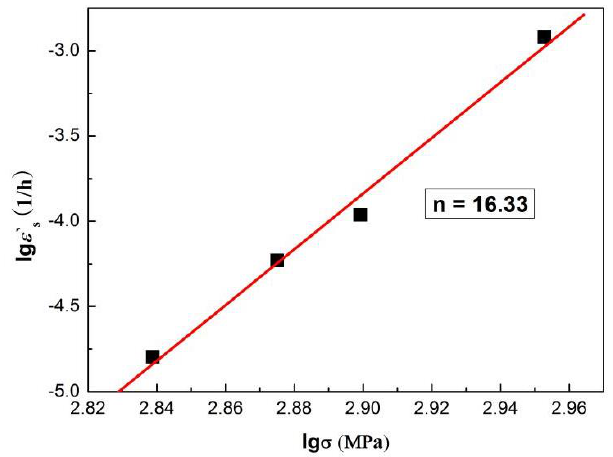
· ε s -lg σ a of IFed alloy at 705